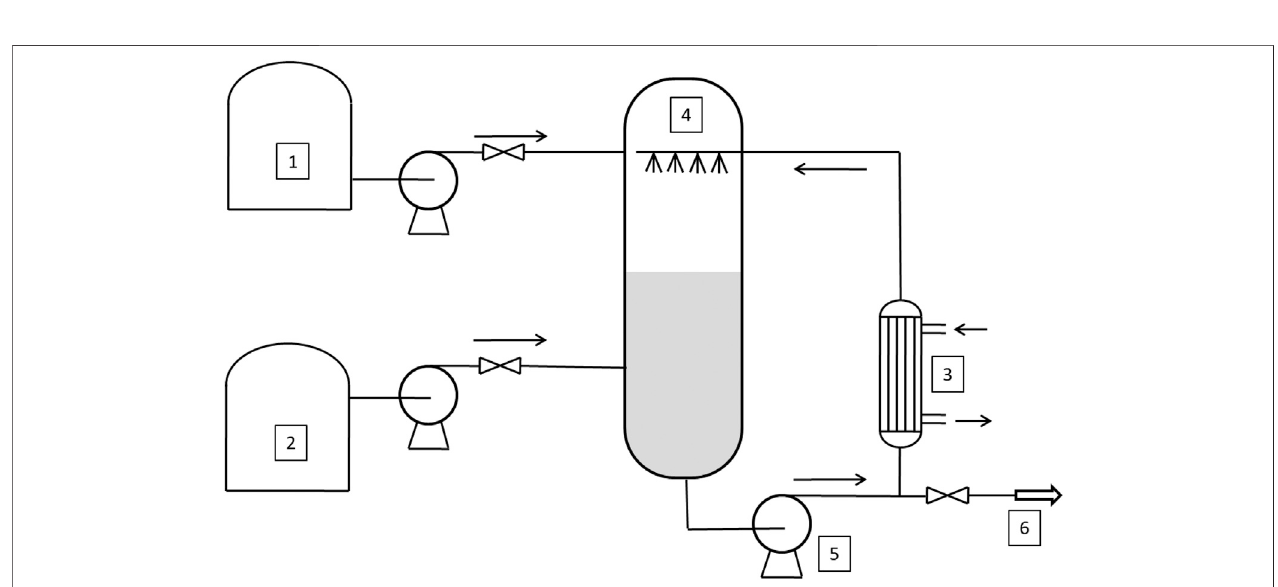
Frontiers in Chemical Engineering |